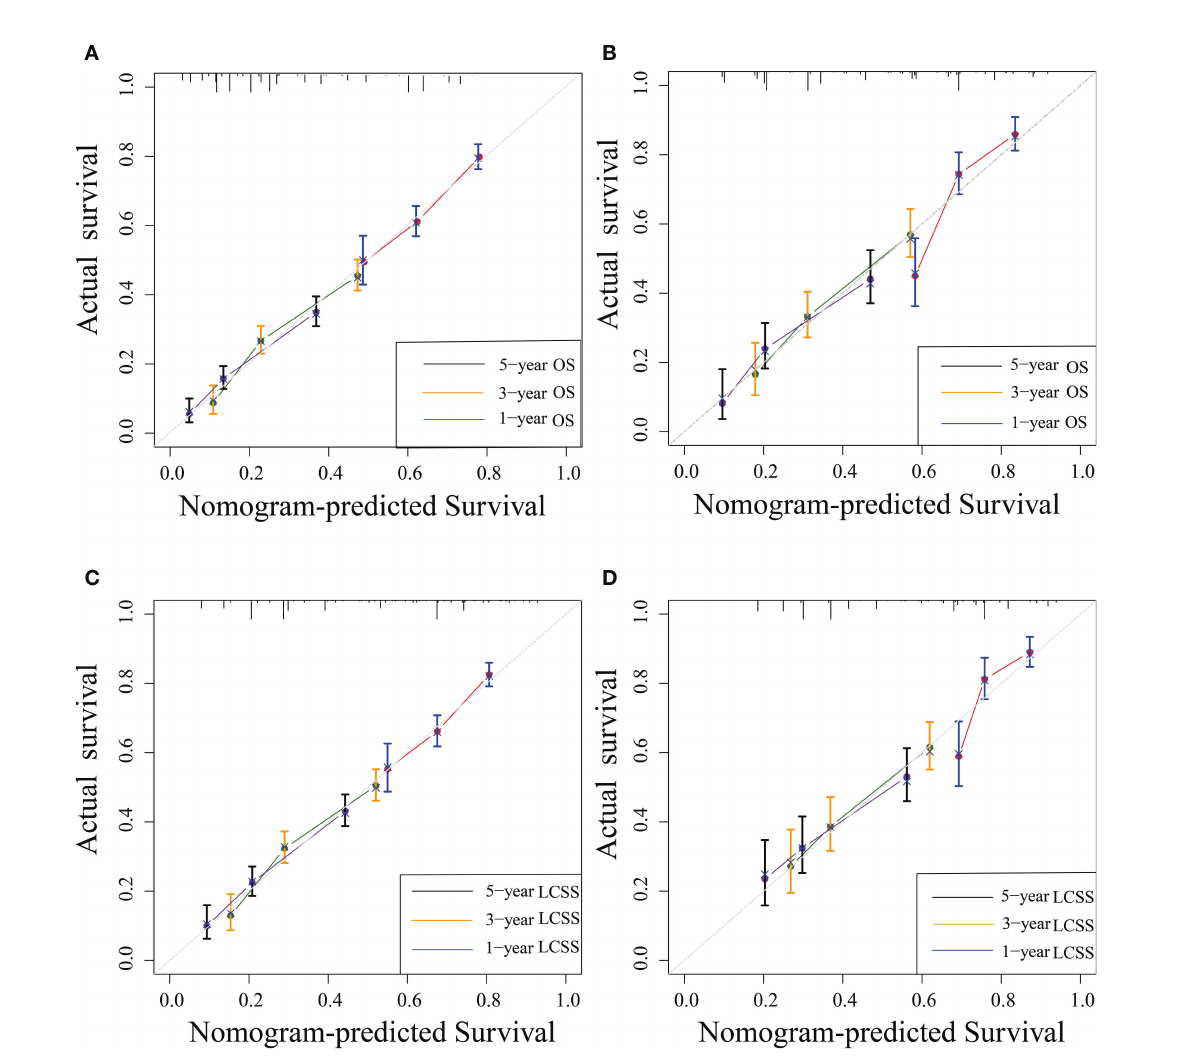
FIGURE 5 Nomogram calibration curves for nomogram-predicted survival (x-axis) and actual observed survival (y-axis). Calibration curves for OS (A, B) and LCSS (C, D) in the training (A, C) and validation cohort (B, D) ; curves for 1-, 3-, and 5-year OS and LCSS were present as blue, yellow, and black lines, respectively. OS, overall survival; LCSS, lung cancer-speci fi c